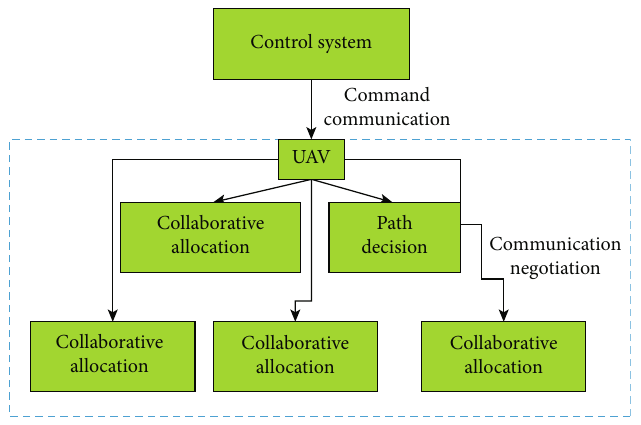
Figure 1: Internal framework structure management fl ow chart of UAV system.